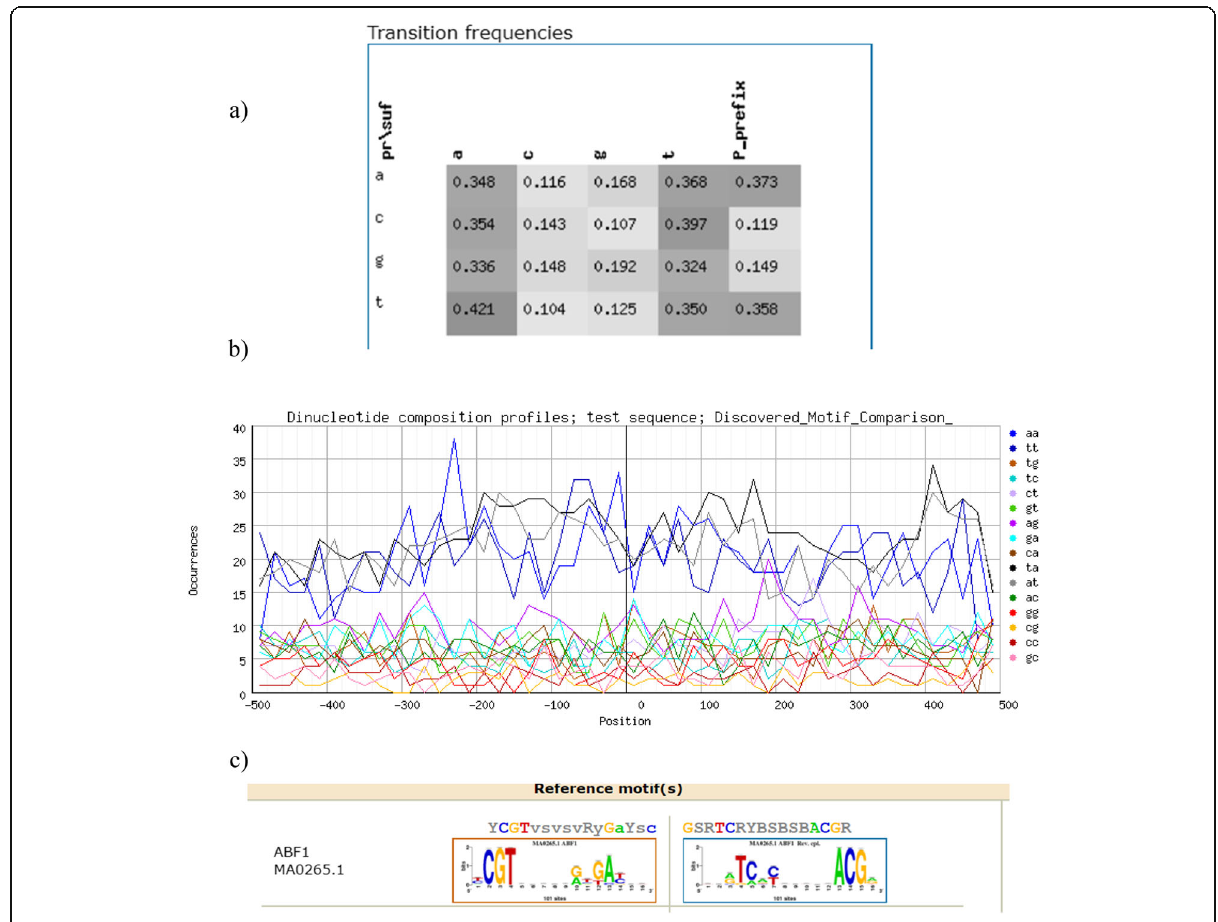
Fig. 5 Dinucleotide composition profile ( a ), nucleotide position peaks ( b ), and number of occurrences along centered peak ( c